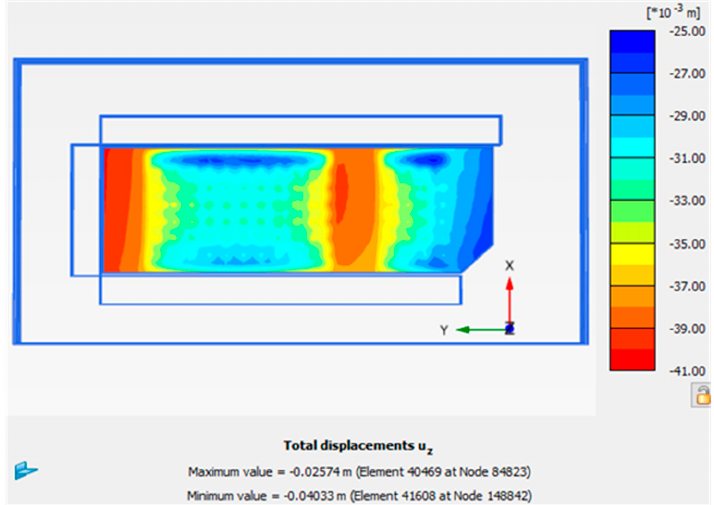
Figure 16. Settlement nephogram in the raft of high-rise buildings.